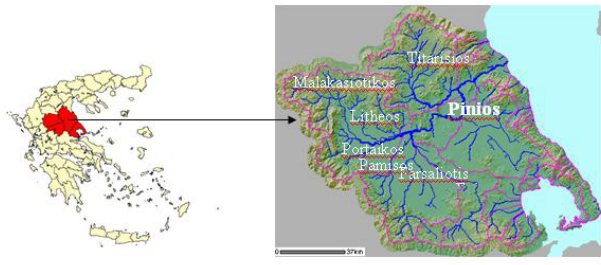
Fig. 1. Geophysical map of Thessaly Figure1. Geophysical map of Thessaly region. 3